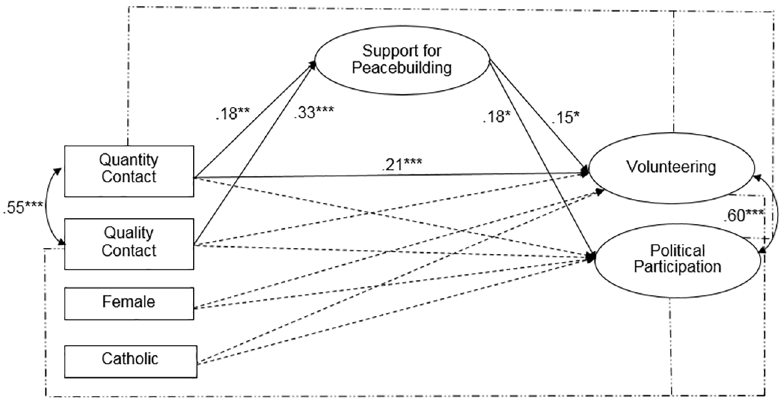
Figure 1. Structural equation model of support for peacebuilding as a mediator between youth quantity and quality intergroup contact and their levels of volunteering and political participation in Northern Ireland. Standardized coefficients (β) are reported. Error variances are omitted from the model for readability. Black full lines represent significant paths, dashed lines are non-significant, and dotted lines represent the indirect